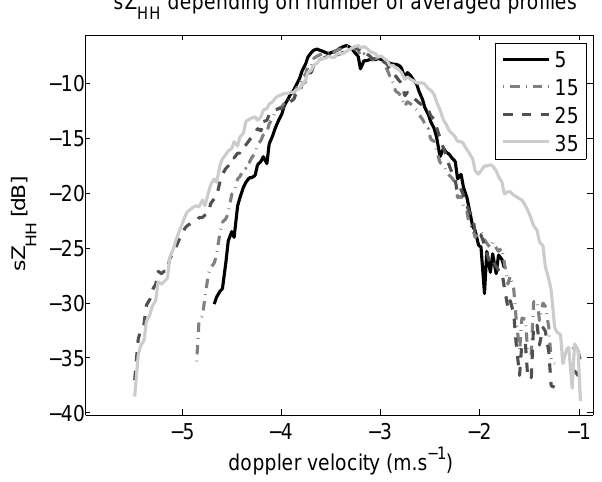
Fig. 6. Broadening effect of sZ HH (v) when an increasing number of spectra is